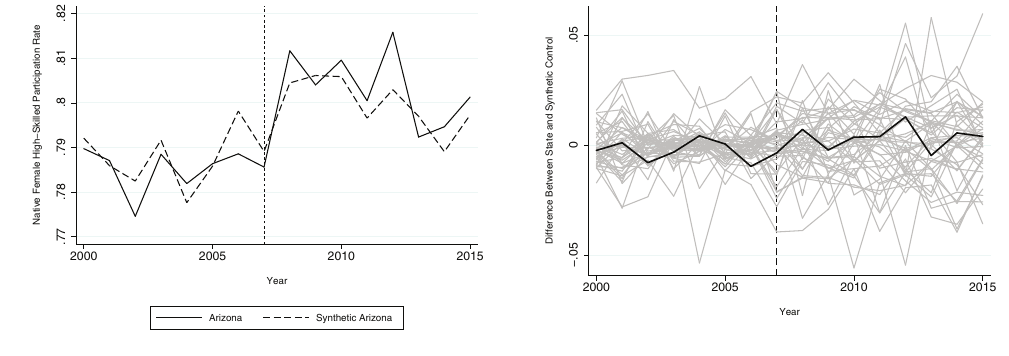
Native high-skilled female participation